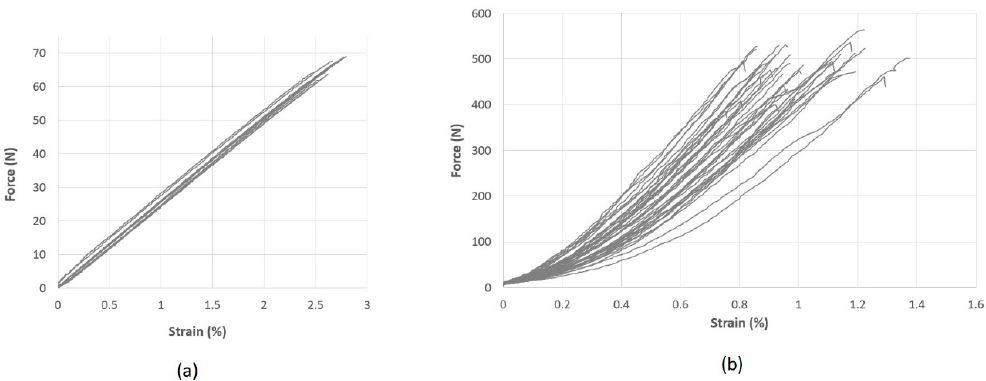
Figure 4. Force-strain curves of ( a ) knitting yarn glass fiber (GF) / polyamide (PA) 6.6 230 tex (10 samples)